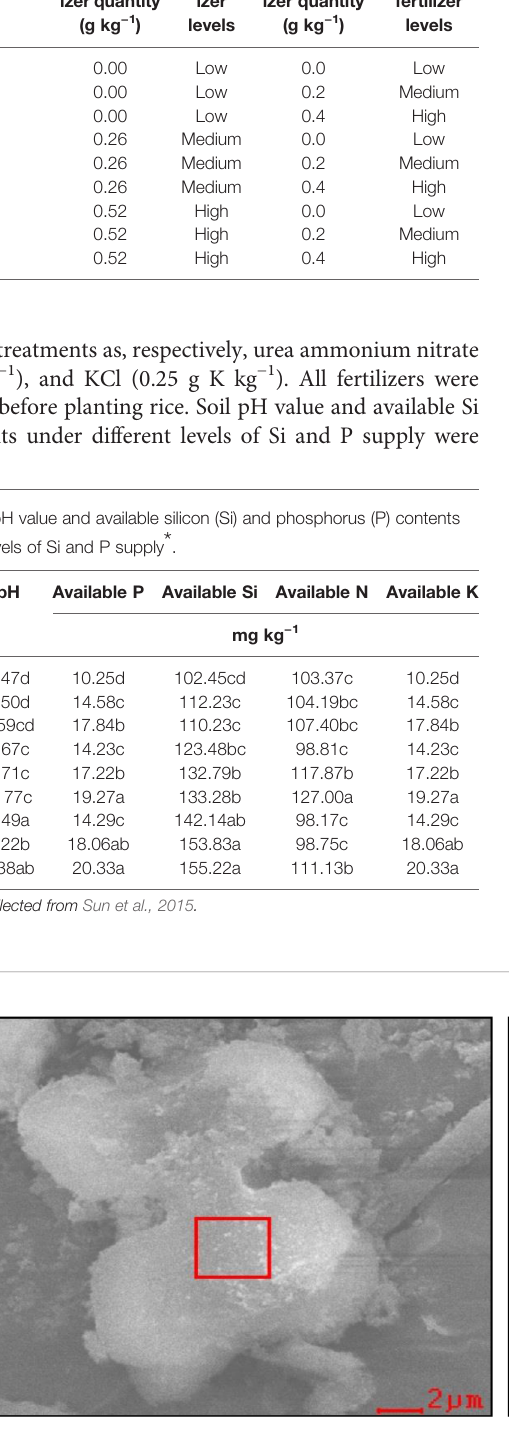
TABLE 1 | The pot experimental design, as designed following silicon (Si) and phosphorus (P) levels. Different lowercase letters indicate signi fi cant differences among all treatments [least signi fi cant difference (LSD) test; p < 0.05, n = 5]. Number Treatments SiO 2 fertil- izer